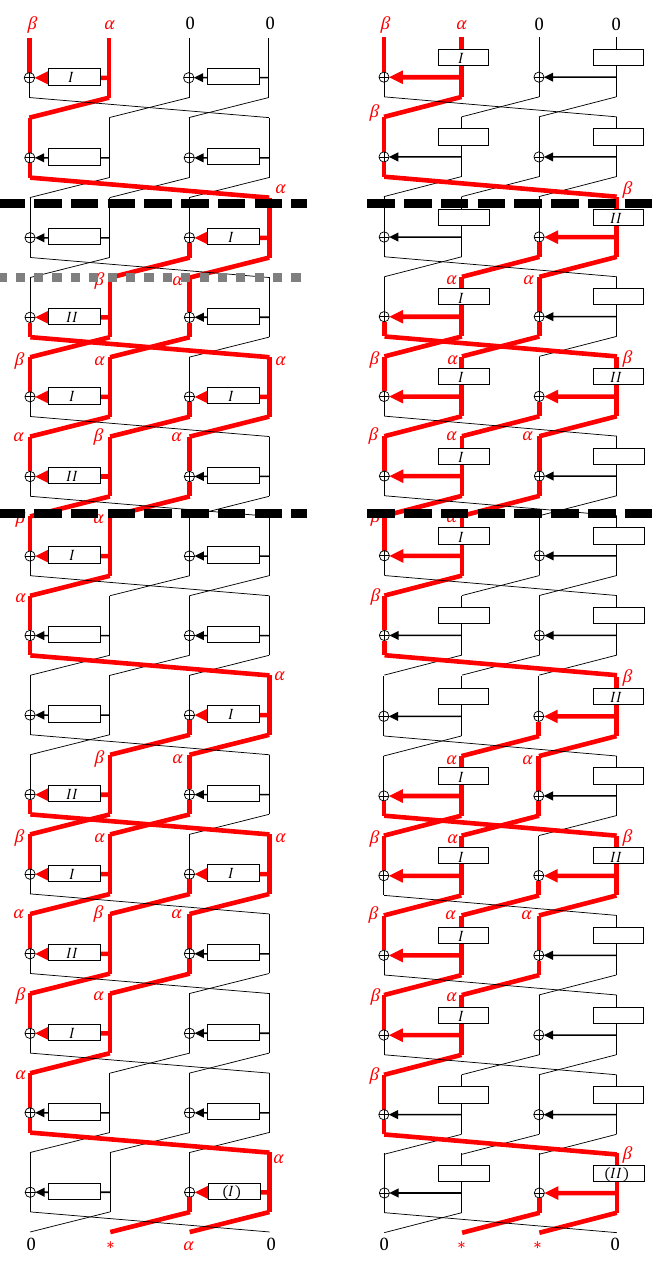
Figure 9: Left: 15-Step Distinguisher for sLiSCP . Right: 15-Step Distinguisher for sLiSCP-light . I and II denote the differential propagation α → β and β → α , re- spectively. ( · ) denote that the differential propagation is not controlled, hence the output difference is unpredictable. The gray dotted line and black broken line are the border between the inbound and outbound phases in the previous work and our work,